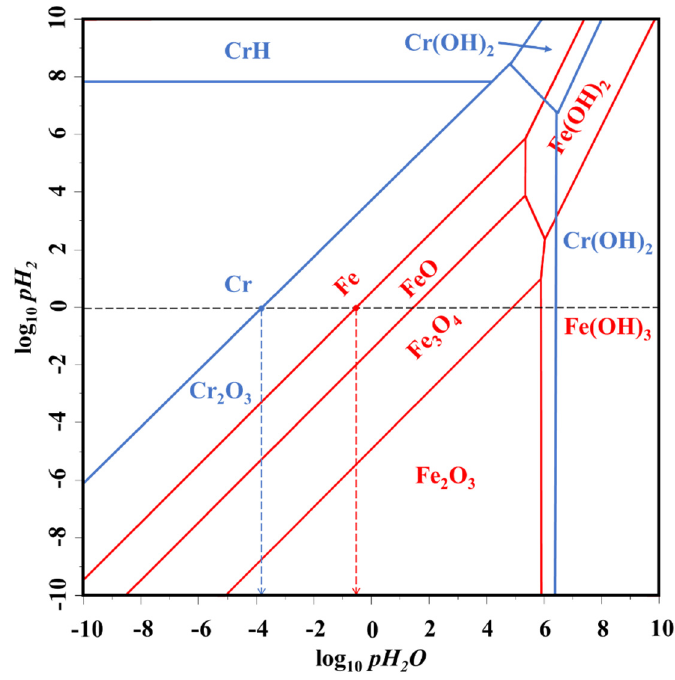
Figure 2. Phase stability diagrams of the (Fe, Cr)-H 2 -H 2 O system as a function of partial pressure of H 2 and H 2 O at a temperature of 1000 °C.